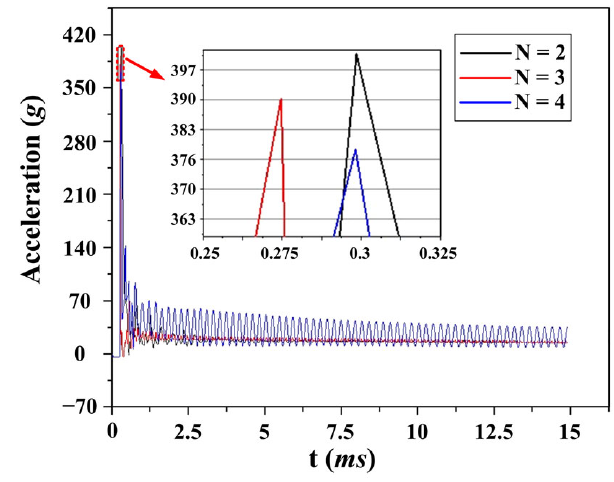
Figure 6. Acceleration of mesh with different size.